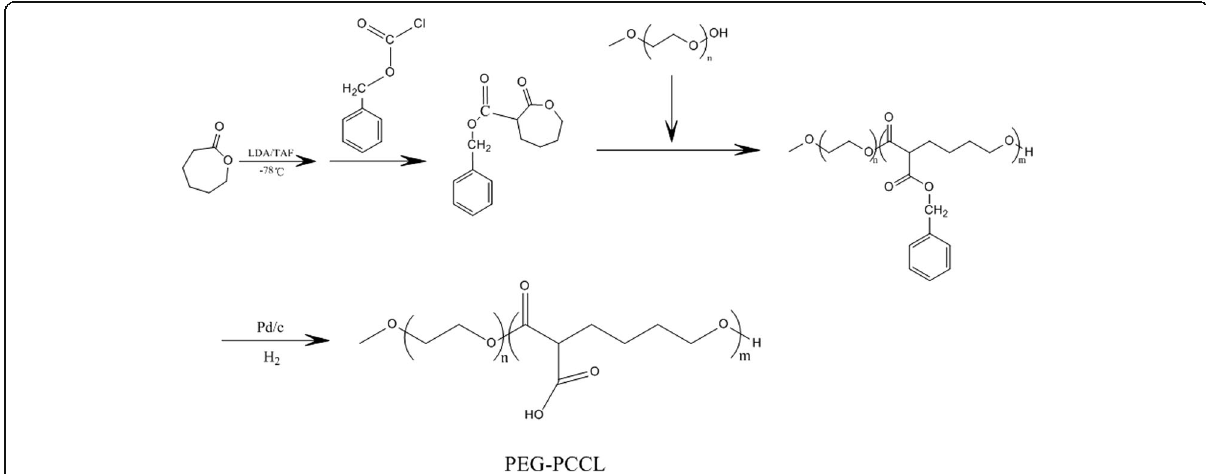
Fig. 1 The flow diagram of synthesizing the PEG-PCCL